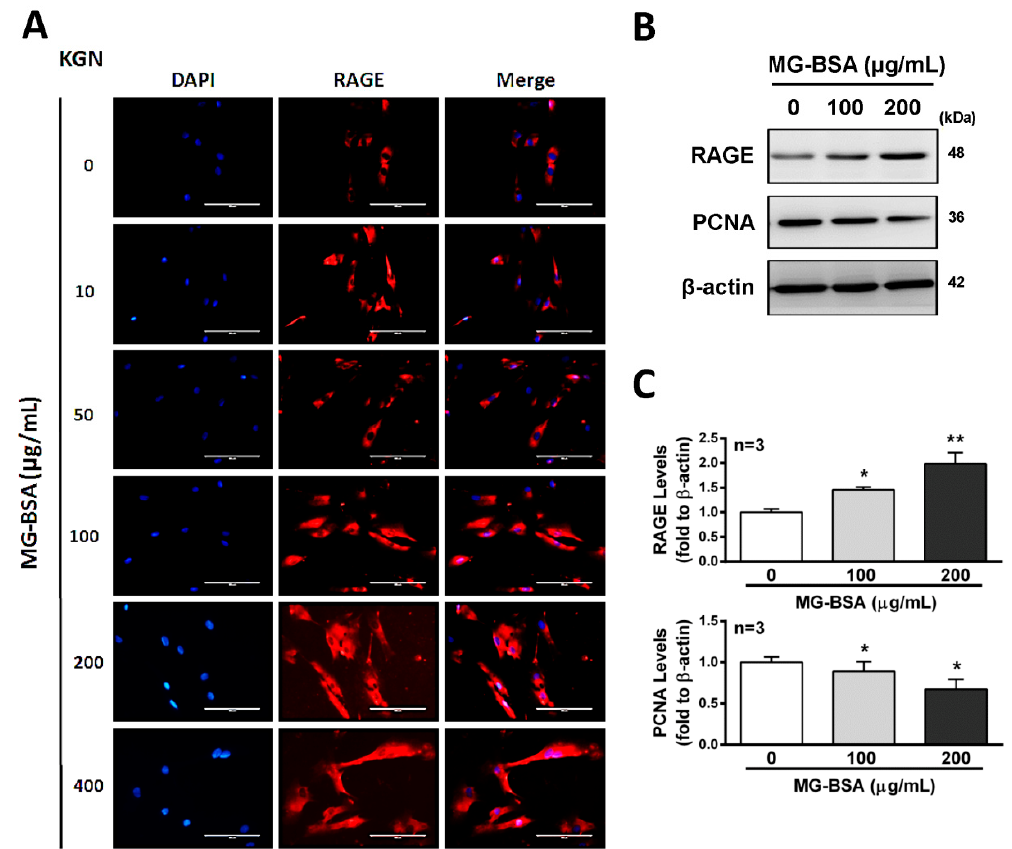
Figure 3. Increasing levels of RAGE in KGN cells treated with MG-BSA. KGN cells were treated with MG-BSA in serial doses for 48 hr. ( A ) Fluorescence microscopy analysis of the expressions of RAGE (red) in KGN cells. DAPI (blue) was used to counterstain the nuclei. The overlay is presented. Scale bar = 100 µ m. ( B ) Western blotting was used to analyze the expression of RAGE and PCNA in KGN cells with MG-BSA treatment for 48 hr. ( C ) Each target protein was normalized to β -actin expression. Data are shown as the mean ± SD ( n = 3). * p < 0.05, ** p < 0.01 compared with the control group. Table 1. Estrous cycle assessment after MG-BSA treatment was summarized as shown in the table. Estrous cycle assessment after MG-BSA treatment No. of No. of No. of Group Total No. Regular Cycle Irregular Cycle Non-Cycle Control 6 6 0 0 MG-BSA 6 2 4 0 DHEA 6 0 4 2 DHEA + MG-BSA 6 0 2